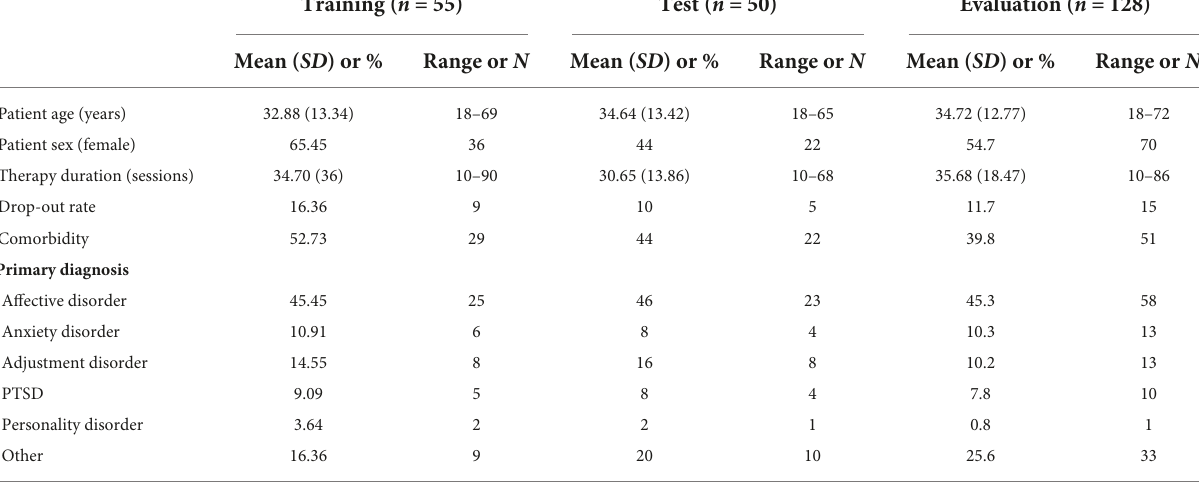
FIGURE1 Flowchart of the sample distribution.